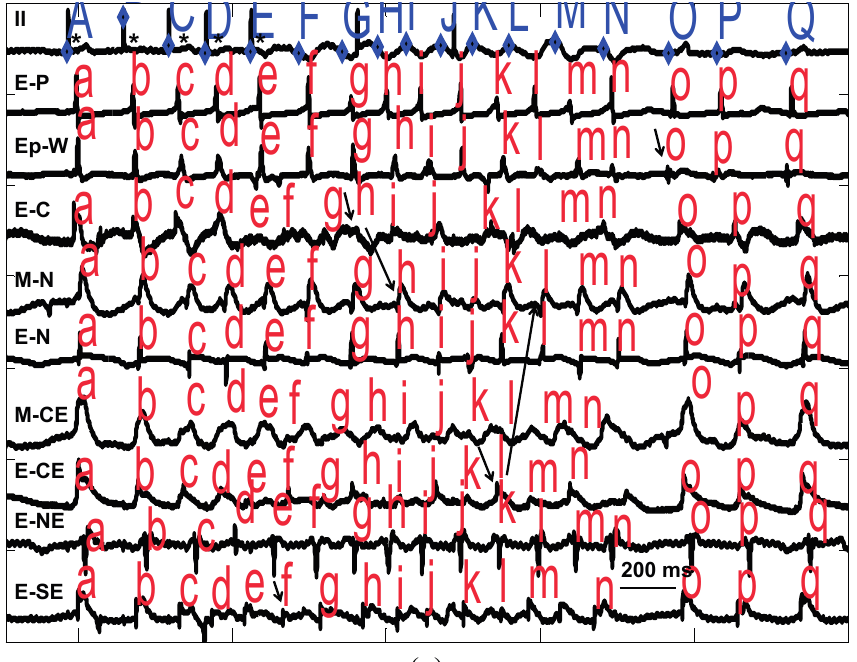
Figure 1. ( a ) Recordings from B1 (Table 4) showing two mechanisms of VT. From top to bottom are recordings from electrocardiogram (ECG) lead II for paced ( * ) complexes A (last drive stimulus) and B–E (4 extrastimuli) and 12 complexes of VT (F–Q) with endocardial (E-) midwall (M-) or epicardial (Ep-) electrograms from pacing site (-P) as well as west (-W), central (-C), north (-N), northeast (-NE), central east (-CE) and southeast (-SE), in the infarct zone producing this VT. Horizonal line (over E-SE) defines 200 ms. Intracardiac activations are marked with lower case letters a–q above each tracing. VT-F is produced by an endocardial focus and VT-H is due to endocardial reentry involving E-C and M-N (Figure 2). Note conduction block between E-C and M-N/E-N consistent with reentry. VT-L is due to reentry between E-CE and M-N despite surface ECG showing similar QRS. The epicardial focus (Ep-W) gives rise to VT-O (arrow). All sites of VT origin were ischemic. After BOTH drugs no focal VT/VF was induced, but reentry VT continued to be induced; ( b ) Electrograms from B1 ( a ) showing VT-H due to endocardial reentry (ER). Recordings are as 1a (larger labels same as a ) with additional endocardial electrograms from extreme northwest (-NWW), extreme north (-NN), southwest (-SW), and south (-S) of the endocardial focal VT complex F (labeled A) and ER complex H (electrograms identified by arrows and activation sequences by lines). Note the conduction block between E-C and E-N which starts the reentry with circuitous activation around E-C and E-N (see Figure 2 complex H). The first stimulus (S) is complex E in 1a and the second is the next drive which does not capture; and ( c ) Electrograms from B1 ( a ) showing VT-O due to epicardial focal mechanism (EpFo). Epicardial recordings are as ( a ) and ( b ) showing VT complex O in (labeled A) with EpFo identified by arrows). Note all surrounding recordings (see Figure 2 complex O) activate by <50% of the cycle length. This VT was blocked by BOTH